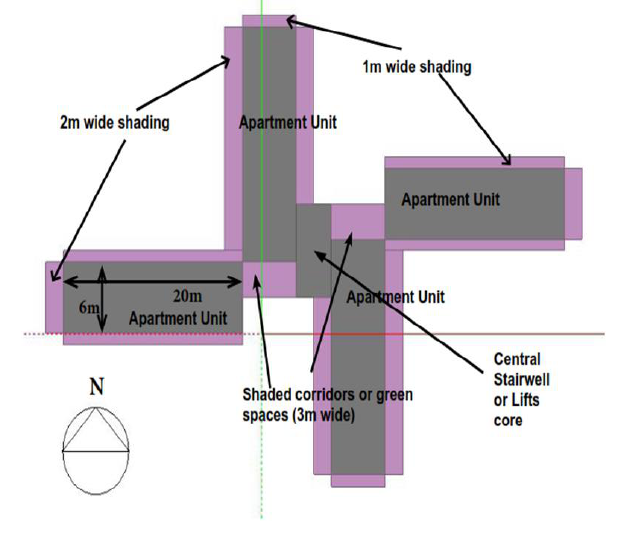
Fig. 6. Option 1 plan view.